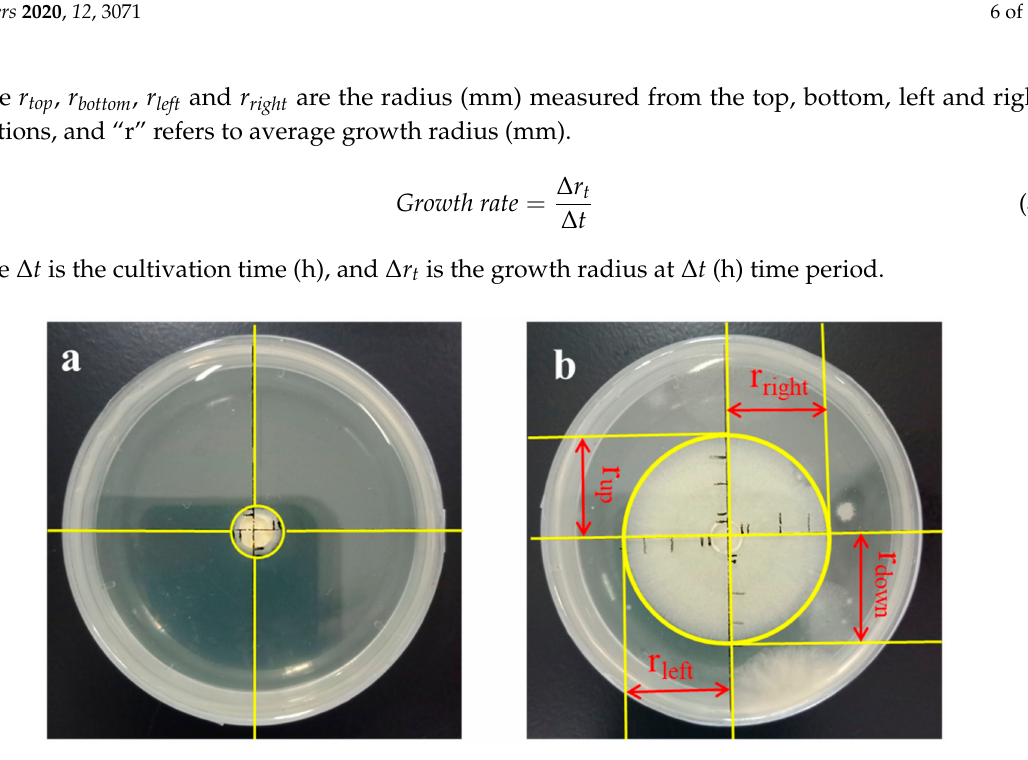
Figure 1. Anti-mold experiment process of tunicate cellulose: ( a ) initial growth of mold and ( b ) growth of mold at time,